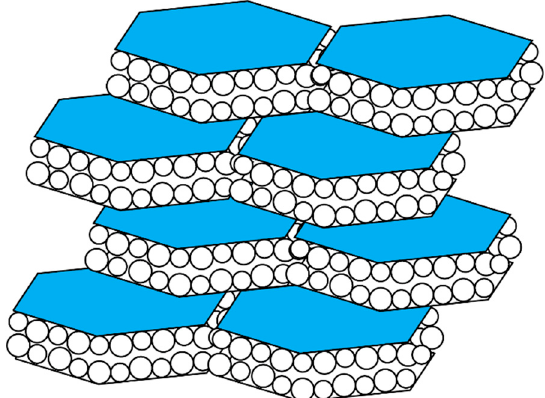
Figure 2. Cartoon representation of a high magnification oblique cross ‐ section through a mollusk shell nacre layer, consisting of “brick and mortar” ‐ arranged hexagonal aragonite tablets that are comprised of spherical mineral nanoparticles. Adapted from references [38–42].